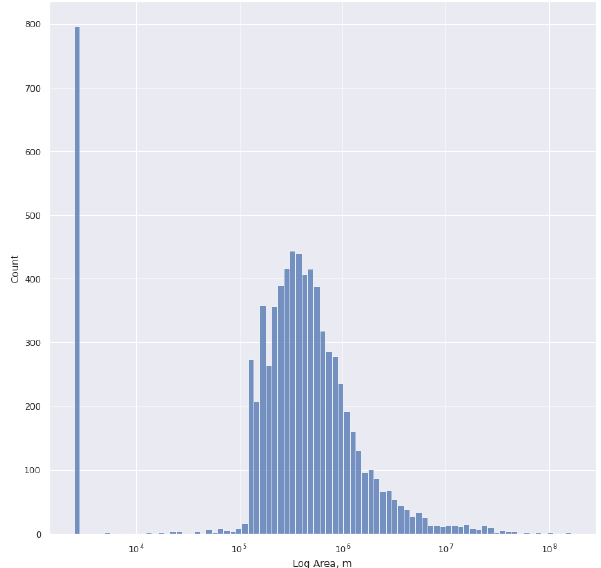
Figure 10. Histogram of the number of recognized lakes on images from Yamal vs the log of lake size